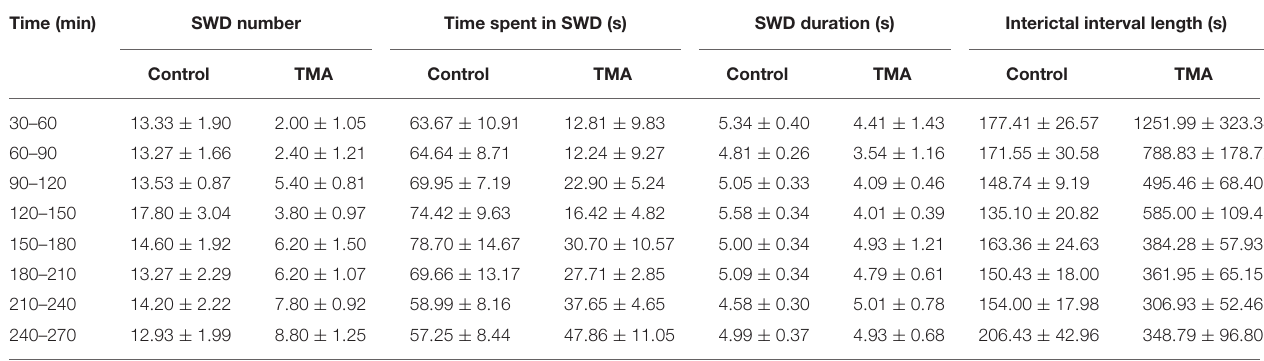
TABLE 1 | Synchronous spike-wave discharge (SWD) parameters in WAG/Rij rats ( n = 5) in control conditions and after i.p. administration of 200 mM trimethylamine (TMA).